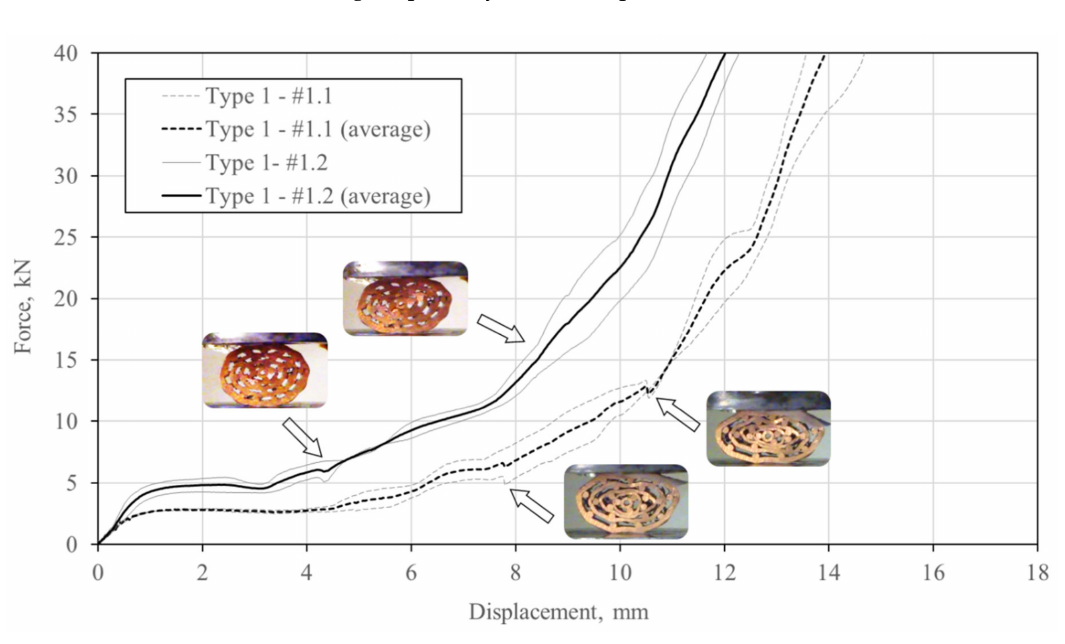
Figure 9. Compressive force–displacement relationship of the type 1